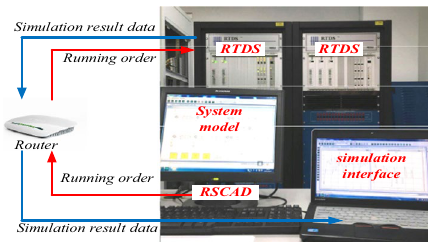
Fig. 7 The experimental setup based on RTDS